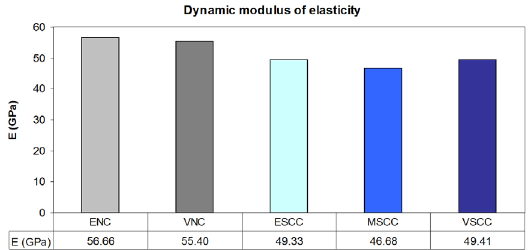
Figure 7. The dynamic modules of elasticity for the tested concretes.